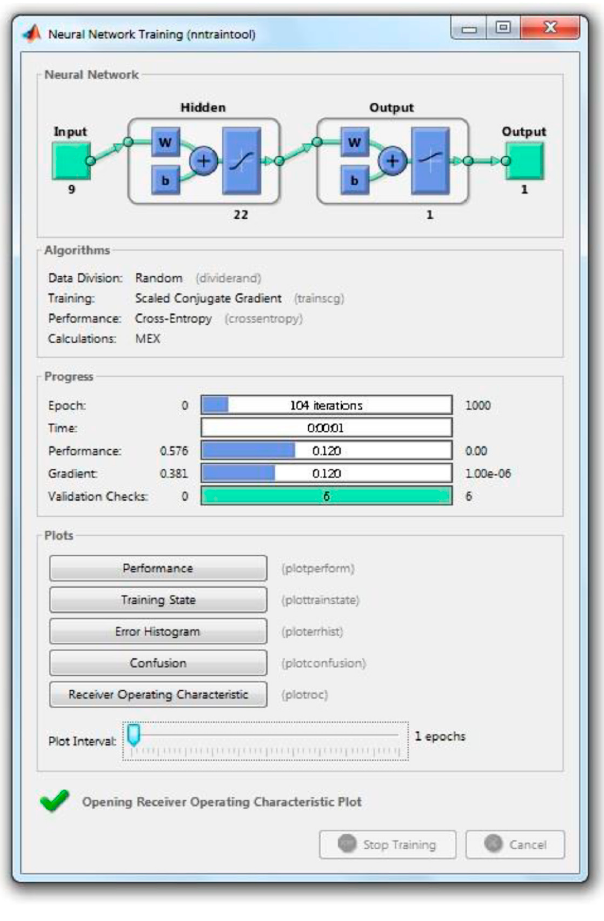
Figure 8. Process of learning of neural network using polynomial coefficients with the degree N = 2.